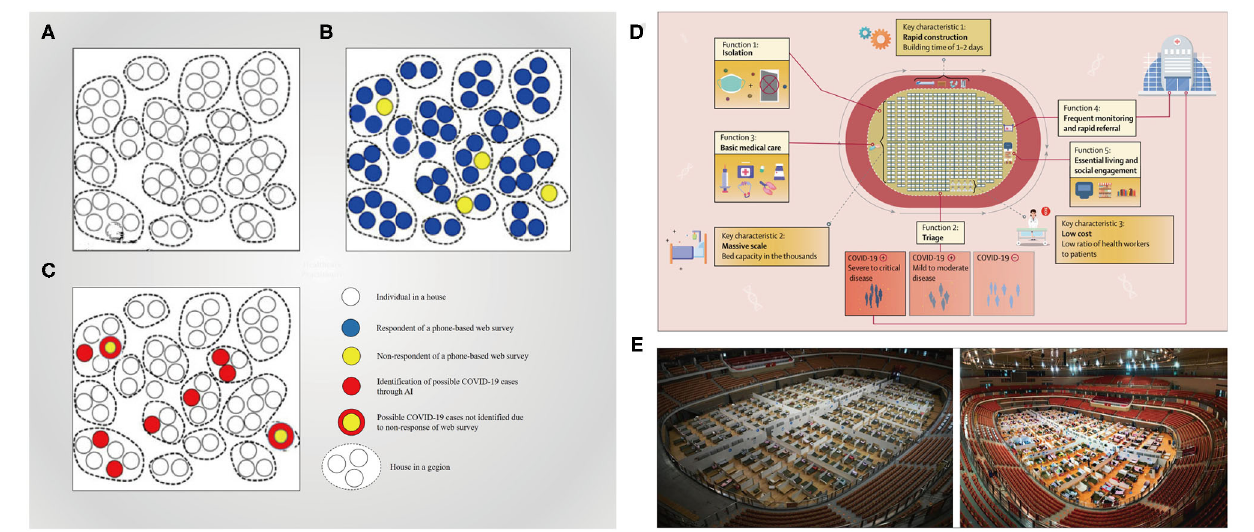
FIGURE 4 | Telemedicine system for the screening and triage COVID-19 patients. (A–C) Conceptual framework of collecting data and identifying possible COVID-19 cases (52); a geographic region (e.g., a village, town, county, or city) with households in it (A) . The respondents and non-respondents of a phone-based web survey (B) . The possible identified COVID-19 cases among the respondents and non-respondents of the survey ( 78) (C) . (D,E) Fangcang shelter hospitals equipped with telemedicine system and their key characteristics and essential functions (